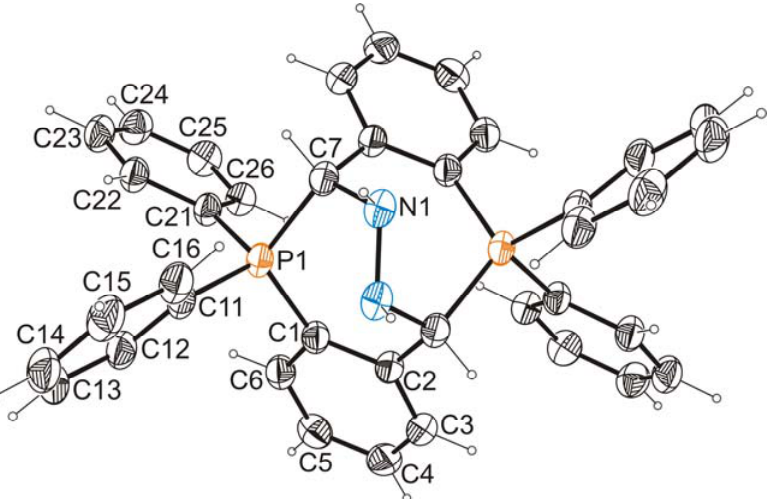
Figure 1. View of the diphosphonium cation present in hydrated and non-hydrated crystals of 1 . Displacement ellipsoids are drawn at 30% probability level. As the molecular cation shown in this figure occupies two-fold symmetry site, the labels indicate only its symmetry independent